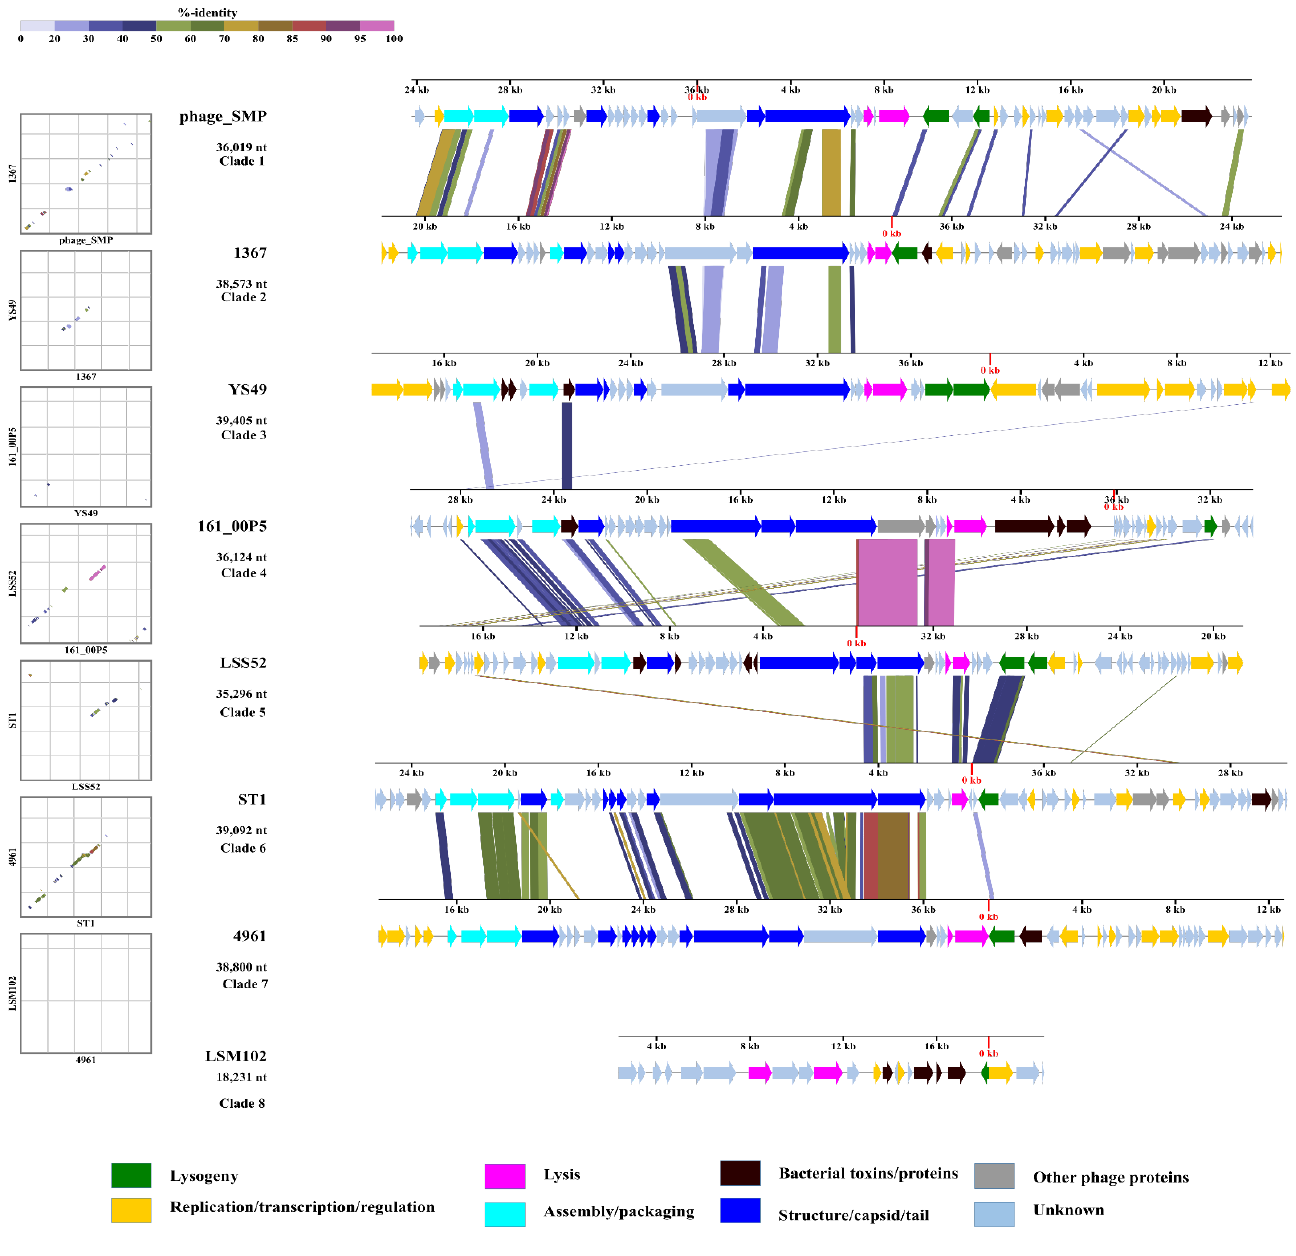
Figure 6. Schematic representation of (pro)phage CDS similarity and organisation. Representative full-length (pro)phage genomes from each clade (of similar genome size) were selected and aligned. Horizontal colour-coded arrows indicate gene function (key on the bottom). Coloured diagonal and vertical lines (alignment) represent percent identity of genes. Dot plot of pairwise alignment indicated on the far left. Colour scale for alignments and dot plots presented in the top left.